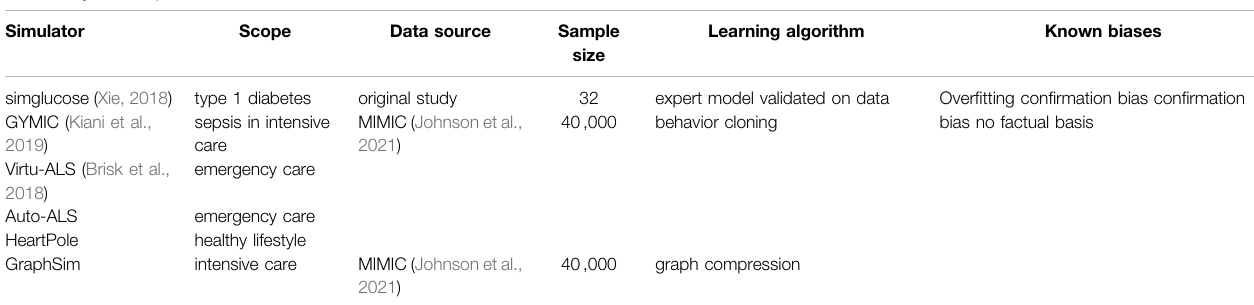
TABLE 2 | Summary of each simulator: trust view.